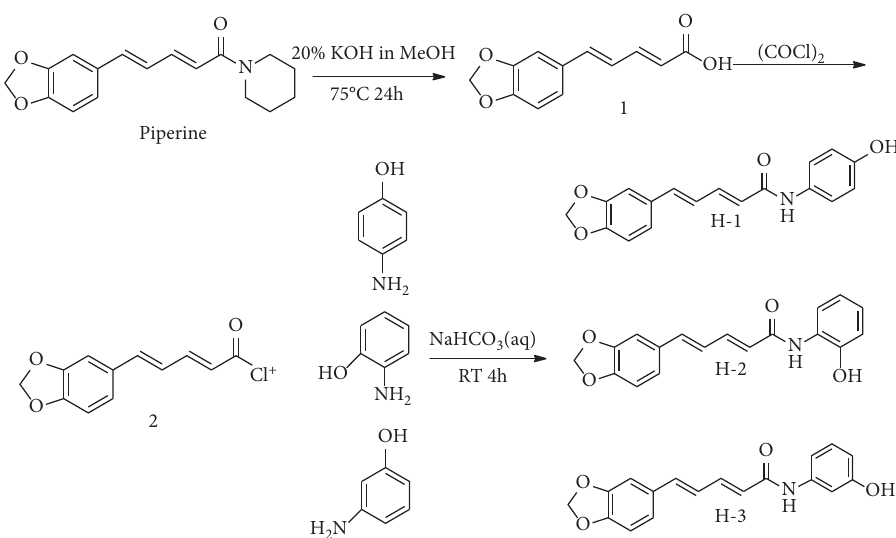
Figure 1: Schematic used in the preparation of piperine